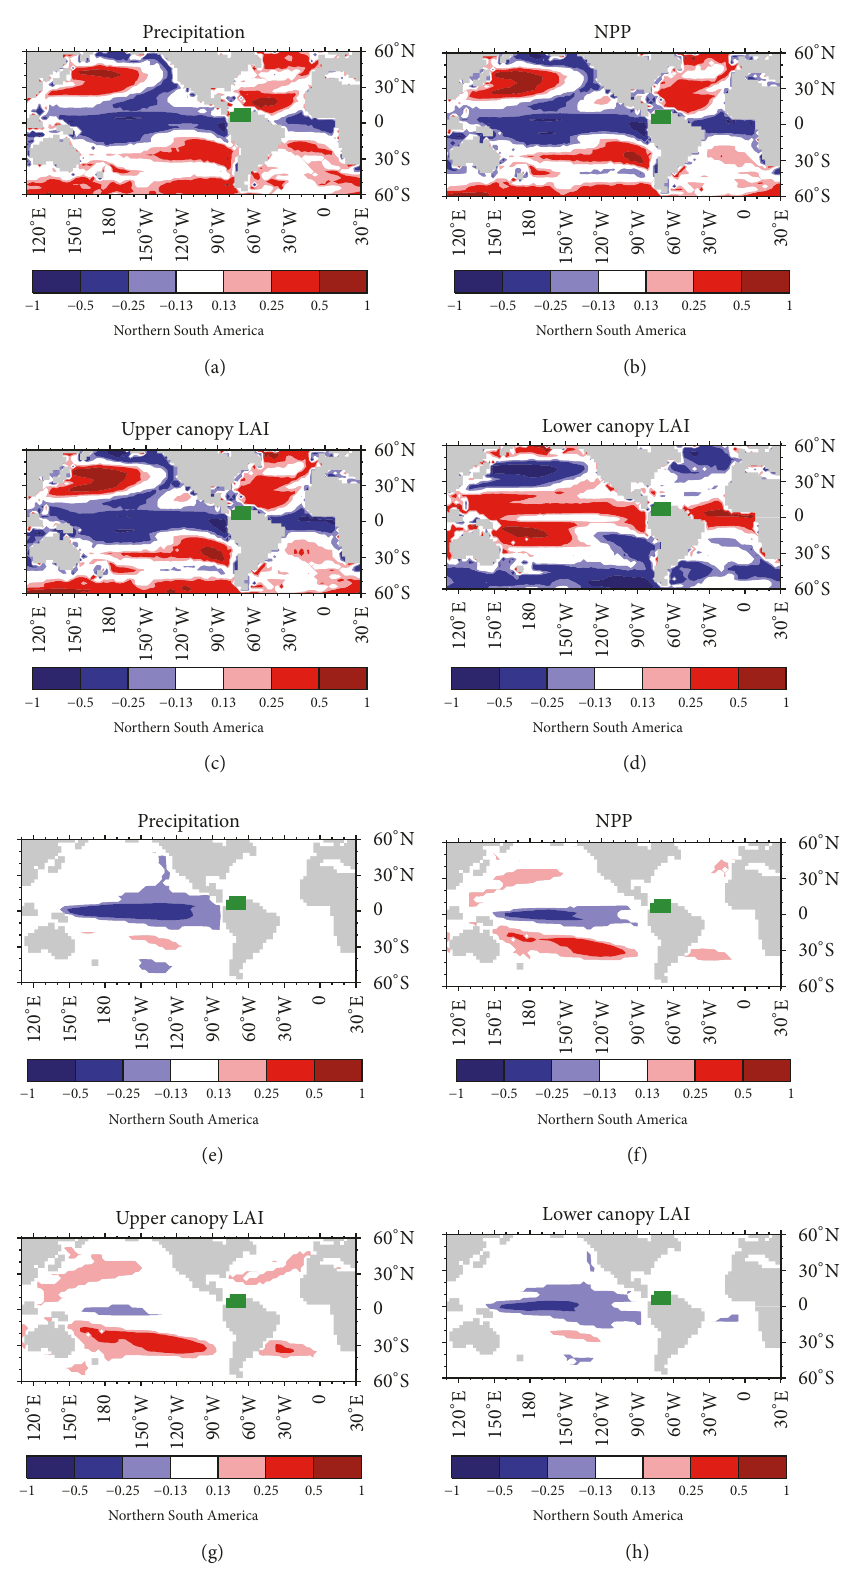
Figure 5: Panels (a–h) illustrate the correlation coefficients between SST and climate and vegetation patterns in NSA 2011–2050, where panels (a–d) are based on increased CO 2 atmospheric concentration for the A2 scenario of IPCC and panels (e–h) illustrate the results without the trend of global warming (see text for details). It should be noted that these figures only show significant values at the 0.01 level of a Student’s 𝑡 -test with a positive or negative correlation of greater than